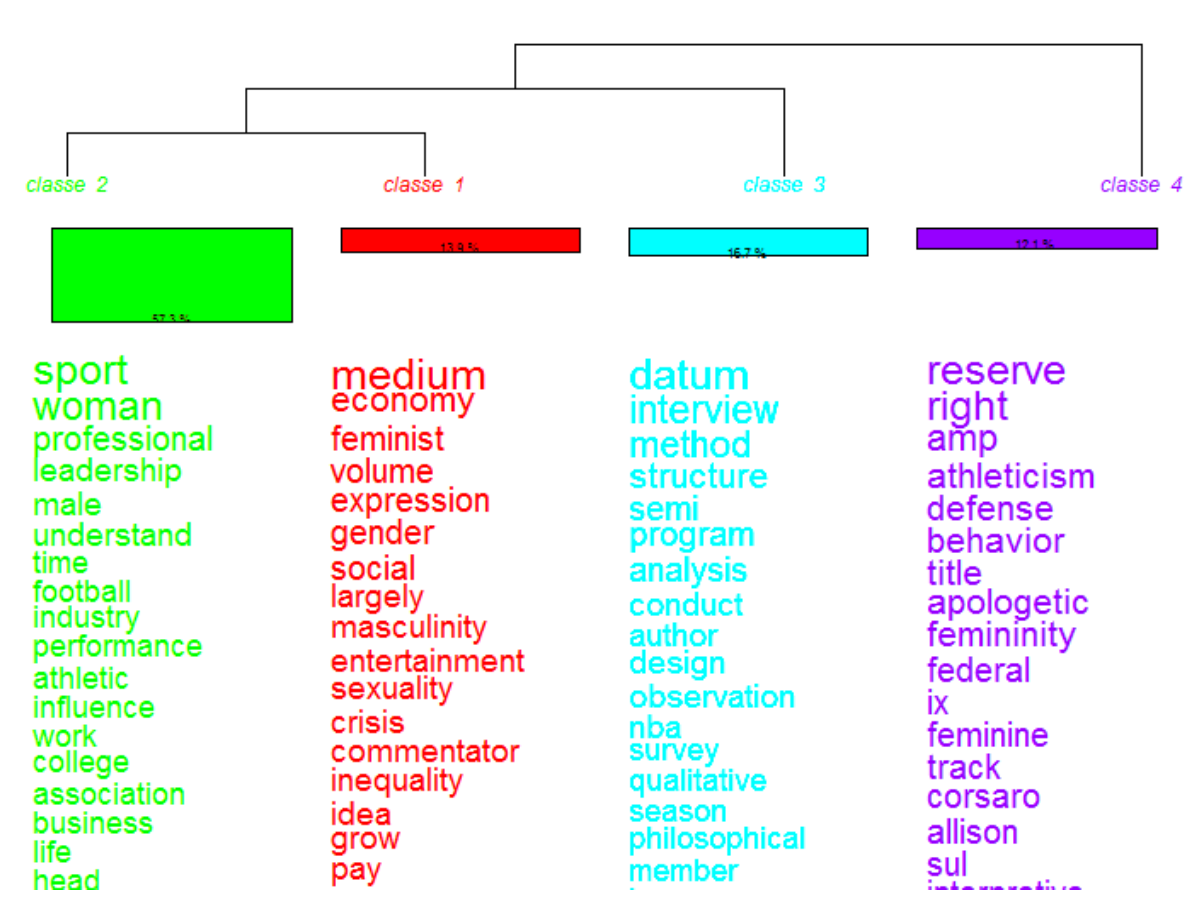
Figure 10. SRL of the professionalization of women’s sport using Reinert’s method.